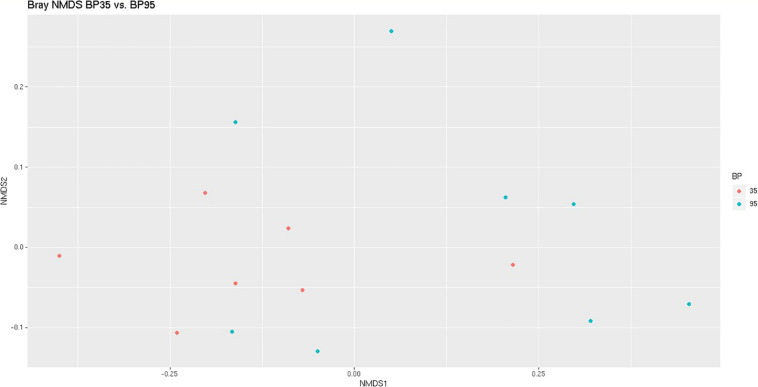
Bray Curtis NMDS plot highlighting differences in the community composition between diets. Different color dots represent samples obtained from rumen simulation technique (RUSITEC) systems incubated with different diets. Red = Concentrate formulated with 35% by-product (BP35), Blue = Concentrate formulated with 95% by-product (BP95).